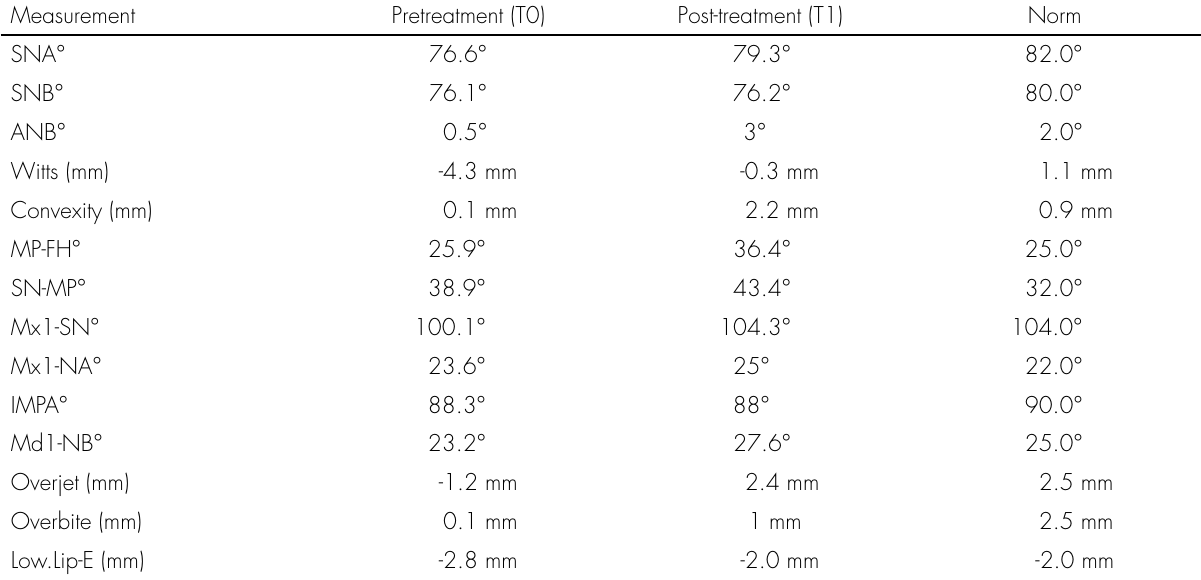
Table I. Cephalometric variables at pretreatment (TO) and post-treatment